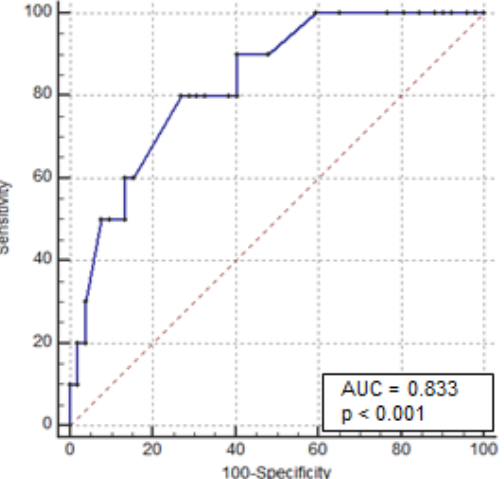
Figure 3. Receiver operating characteristic curves for colectomy based on colonic dilation (X-ray of the abdomen) at admission. the abdomen) at admission.